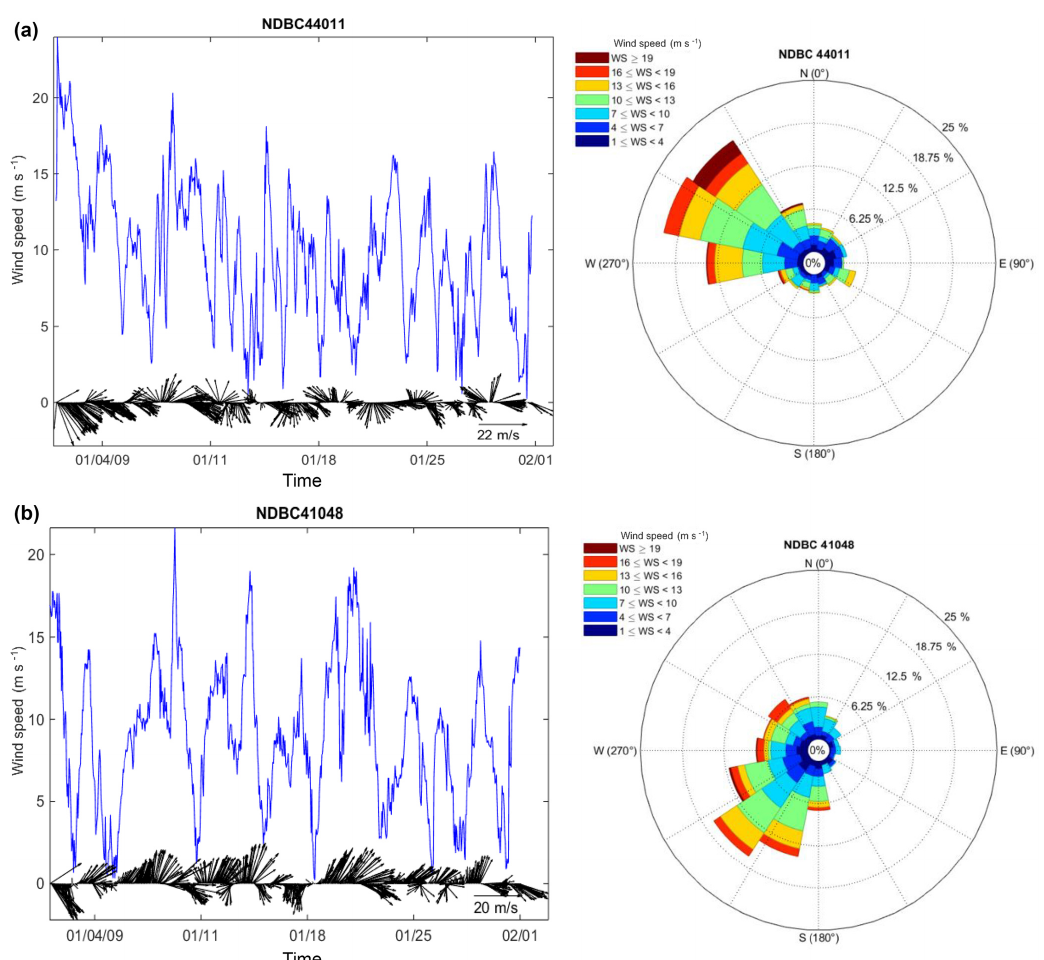
Figure 2. Time series of measured wind speed (lines) and vectors (arrows) and the associated wind roses at NDBC buoys 44011 (a) and 41048 (b)